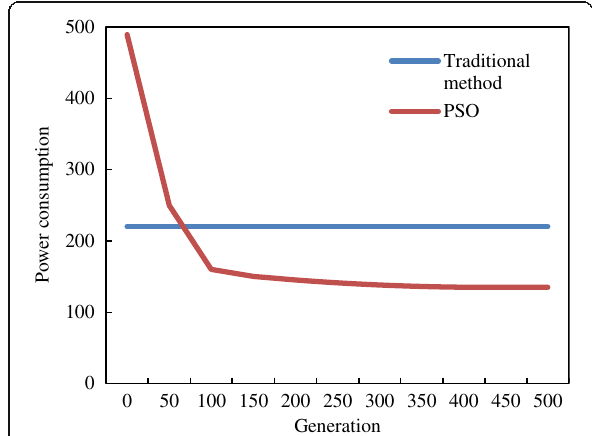
Fig. 7 Comparison of energy consumption. This figure shows a comparison of network power consumption. It can be seen that the power consumption of the network constructed with PSO is smaller than the energy consumption of the traditional